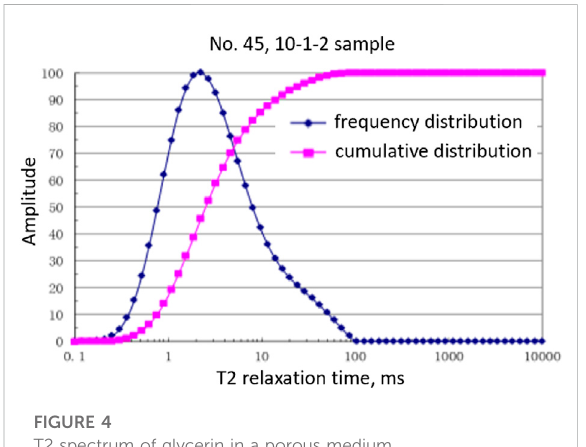
FIGURE 4 T2 spectrum of glycerin in a porous medium.